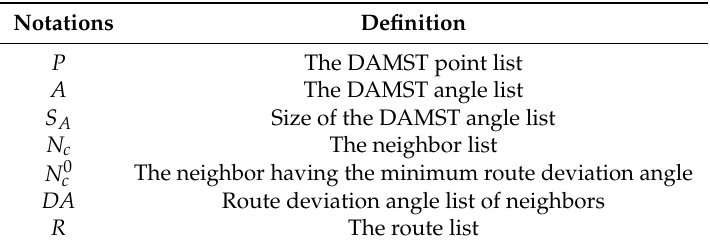
Table 2. Definition of notations.